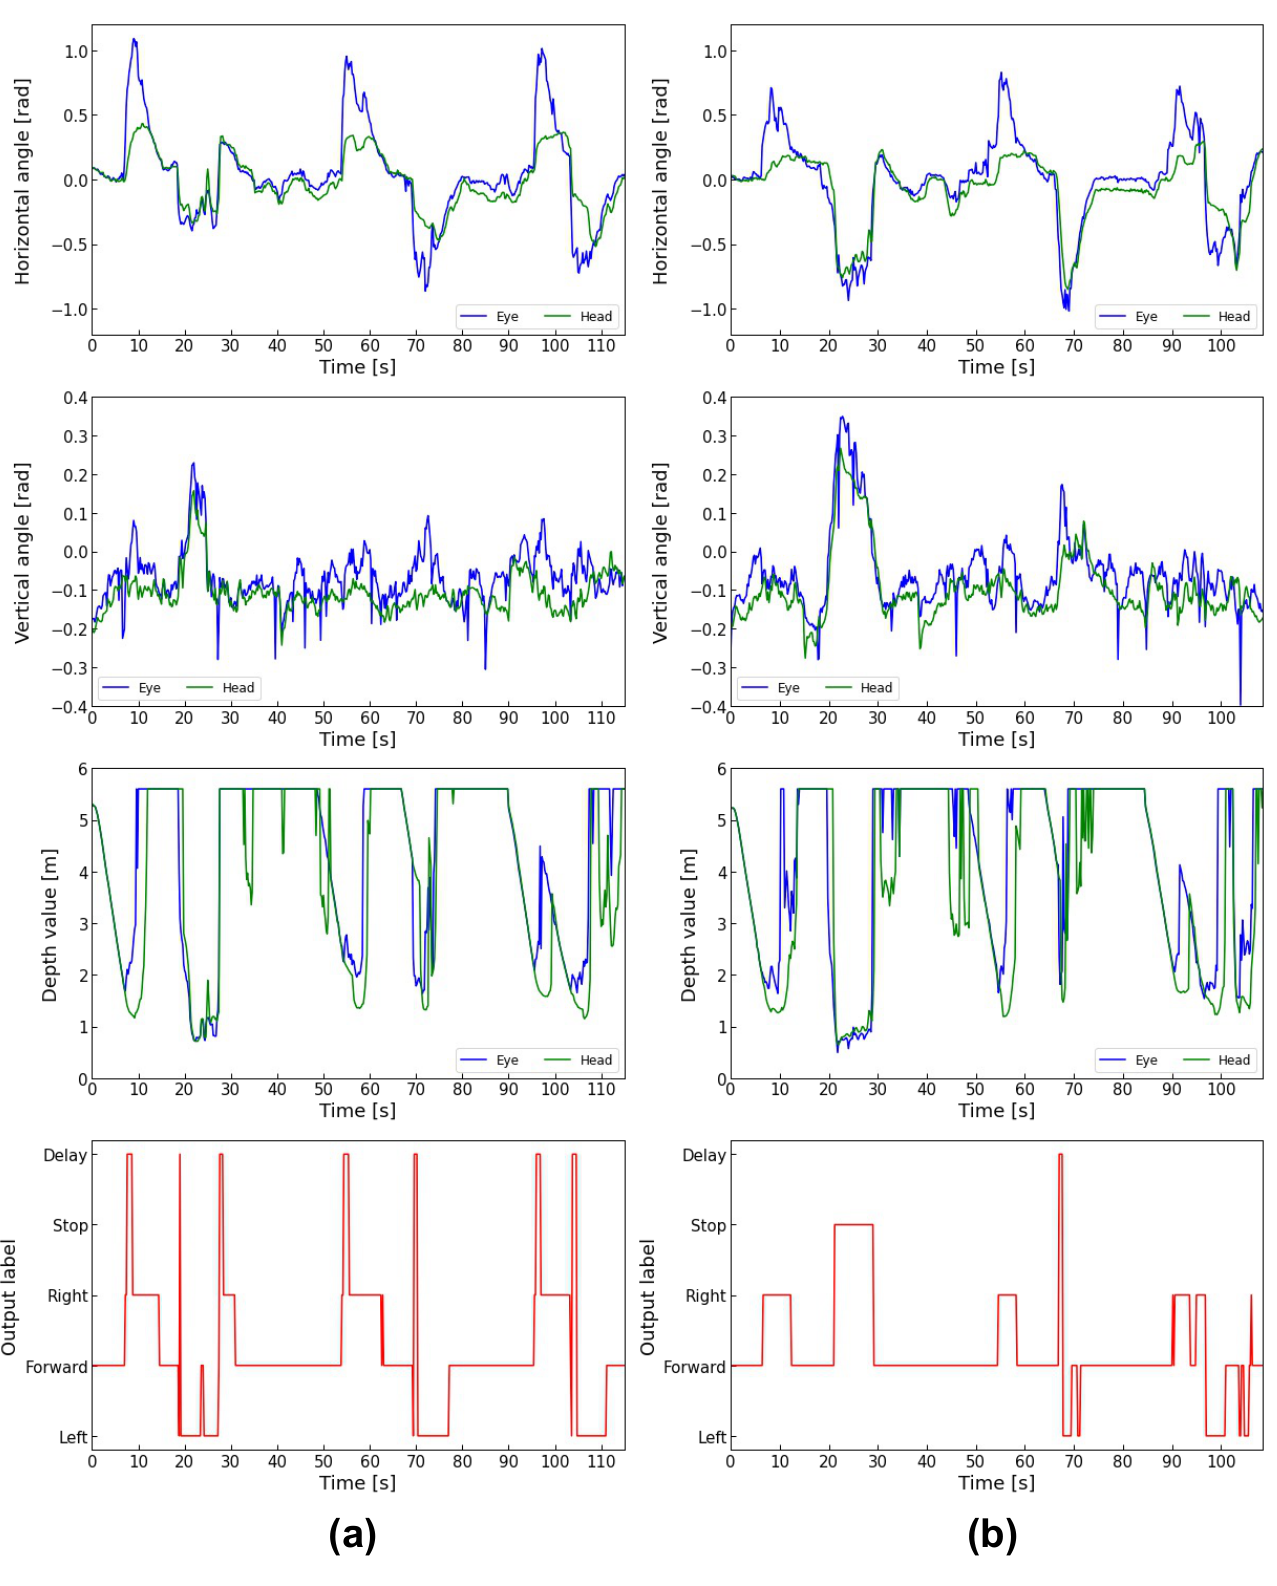
Figure 13. Comparison of Subject A’s driving data: ( a ) Driving data in the traditional method; ( b ) Driving data in the proposed